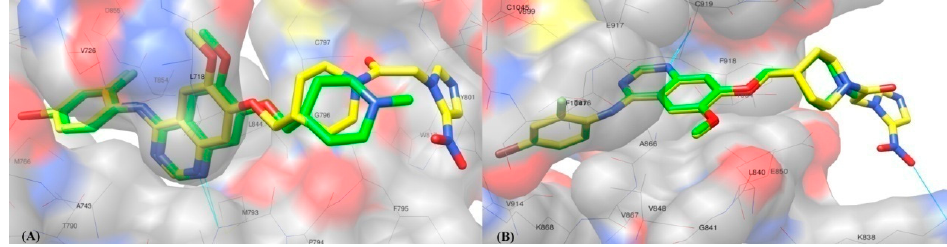
Figure 2. The docked poses of compound 16f (C: yellow; N: blue; O: red) or vandetanib (C: green; N: blue; O: red) at the ATP binding cleft of EGFR kinase ( A ), and VEGFR-2 kinase ( B